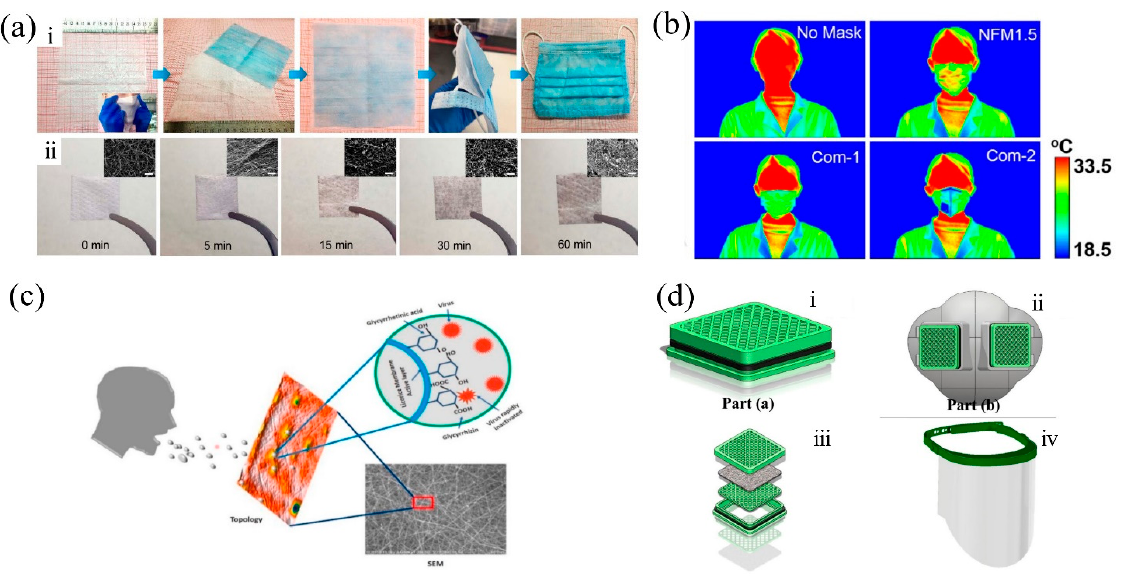
Figure 12. ( a ) ( i ). Photographs of the mask preparation process with 05GOPAN membrane as a wearable air filter. ( ⅱ ) Photographs and SEM images (insets) showing the filter effect of 05GOPAN membrane after filtration of different times. Scale bars: 5 µm. Reprinted with permission from ref. [53]. Copyright 2018 Elsevier B.V. ( b ) Thermal images of bare face and faces covered with NMF1.5 and two commercial face masks. Adapted with permission from ref. [84]. Copyright 2018 Elsevier Inc. ( c ) Virus deactivation mechanism of the antiviral mask. Reprinted with permission from ref. [93]. Copyright 2020 Elsevier Inc. ( d ) Schematic representation of the design of the nanofibrous respirator face mask; ( ⅰ ) depicts the respirator filter containing multilayers of CuONPs/GO@PLA and CuONPs/GO@CA nanofibers. Part ( ⅱ ) represents the fixed part of the face mask. The assembly of the multilayers consisting of nanofibers into a respirator filter is shown in ( ⅲ ). The face shield containing two parts and fabricated via the molding procedure is shown in ( ⅳ ). Reprinted with permission from ref. [92]. Copyright 2020 Elsevier Ltd.